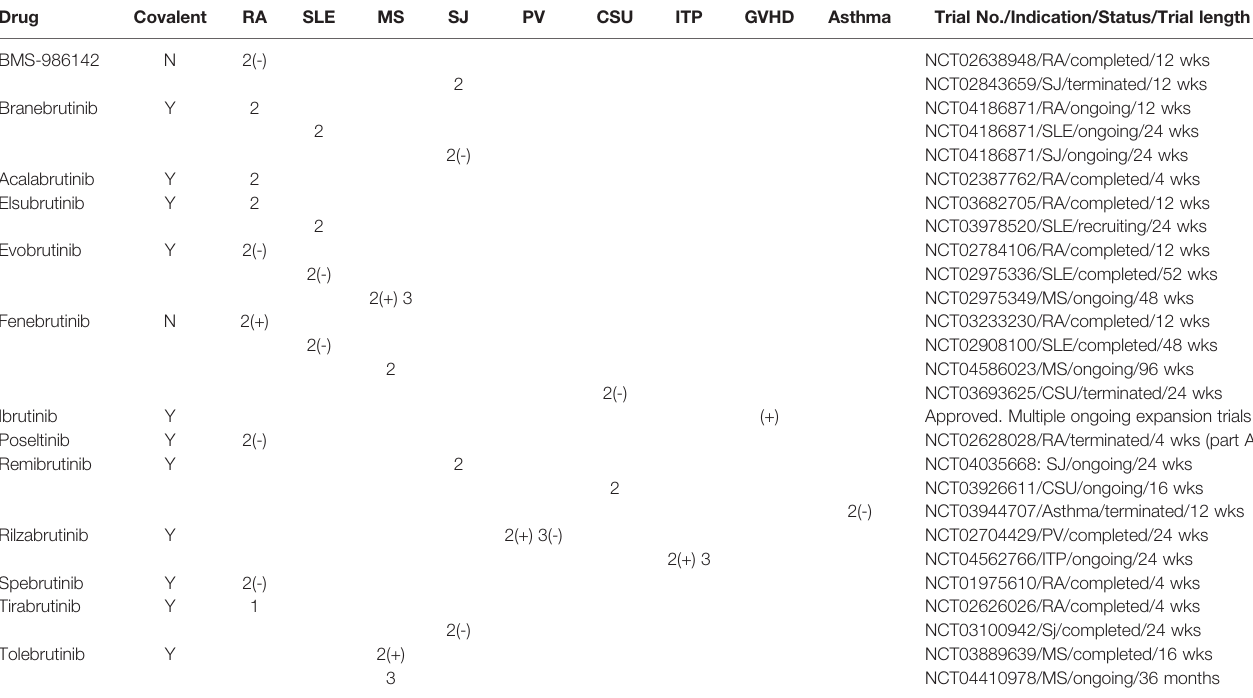
TABLE 1 | Clinical BTK inhibitors in phase 2 or higher clinical trials. BTK inhibitors are listed by registered names if available. Drug